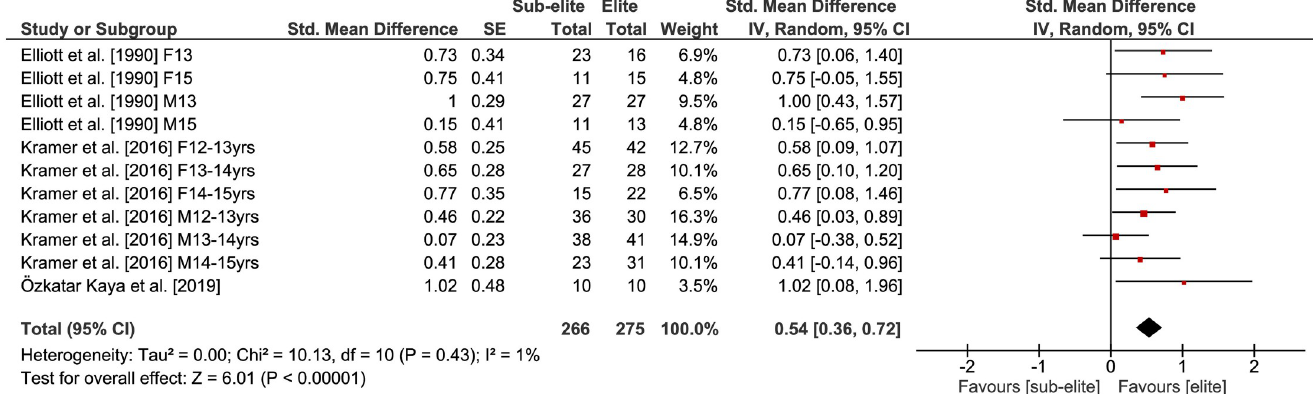
Fig 4. Differences in measures of agility by competition level (i.e., elite vs. sub-elite tennis players). CI = confidence interval, df = degrees of freedom, SE = standard error, IV = inverse variance.